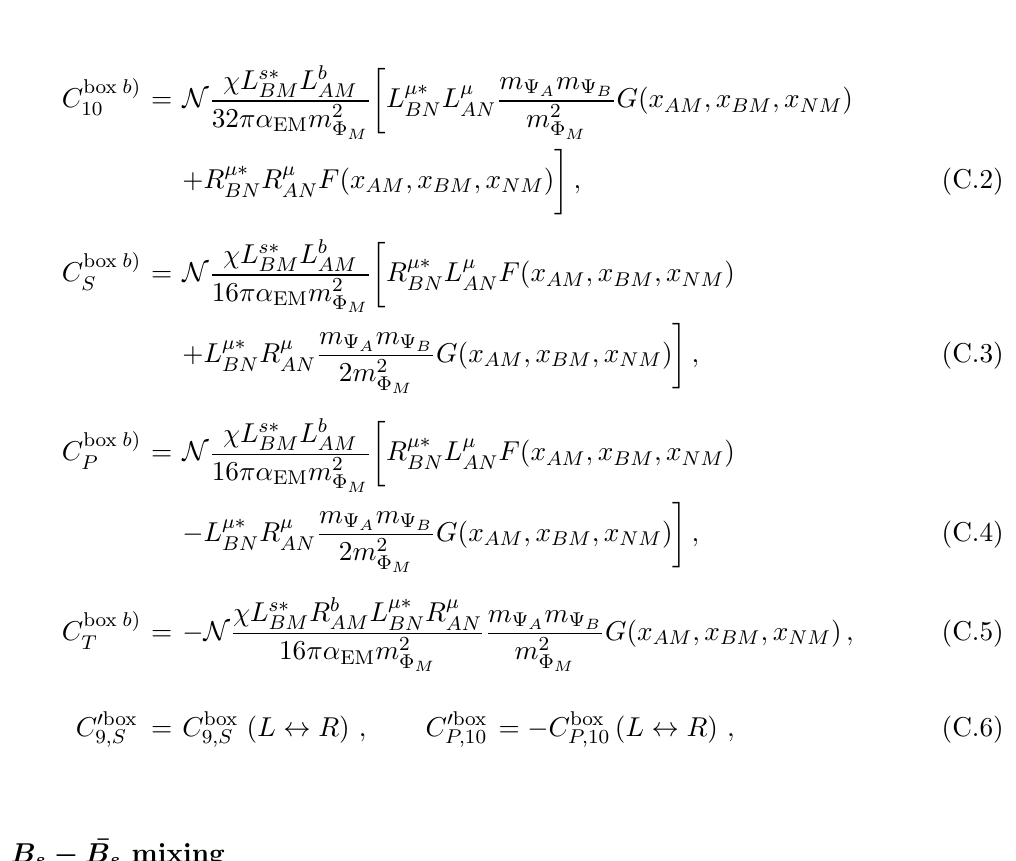
Table 6 . Table of SU(3)-factors entering the box induced Wilson coe(cid:14)cients involved in B s (cid:0) (cid:22) B s mixing for real scalars and Majorana